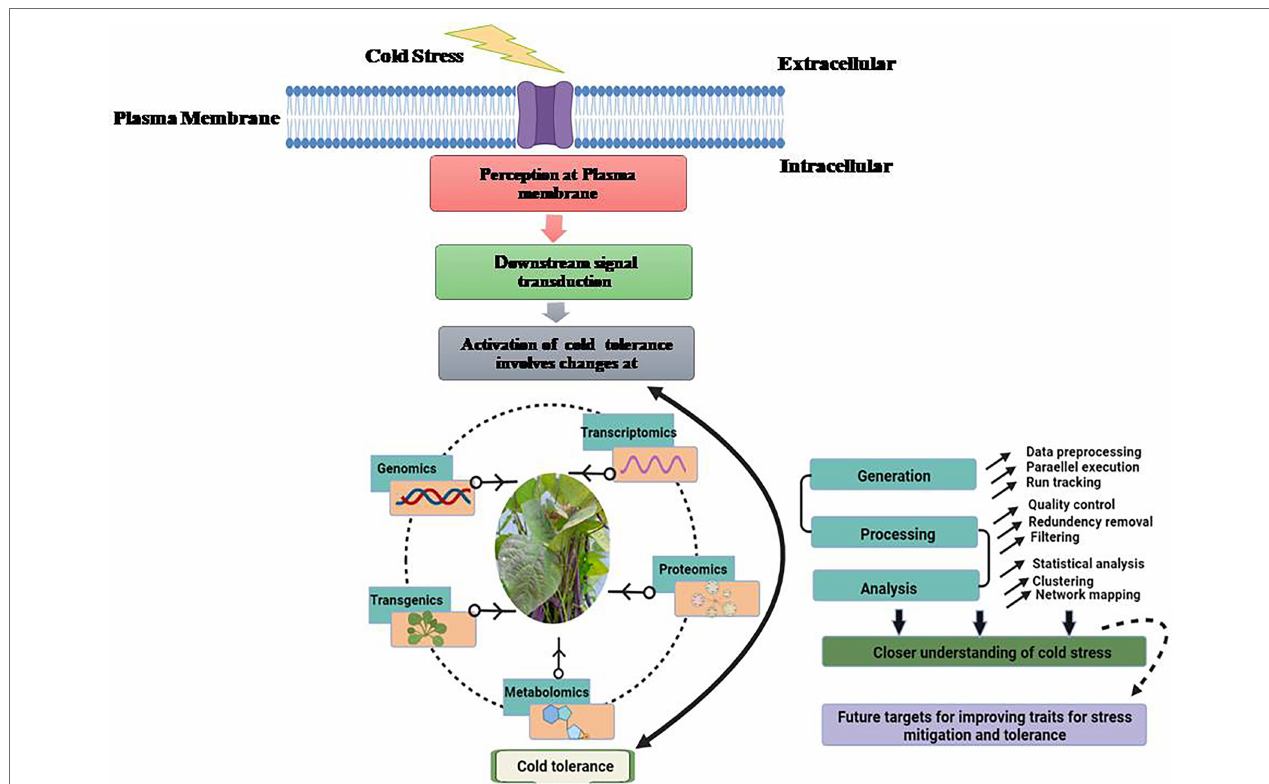
FIGURE 2 | Multi-omic approaches for cold stress tolerance involving analysis of cold stress perception to downstream signaling and data processing with analysis and future targets for improving traits for cold